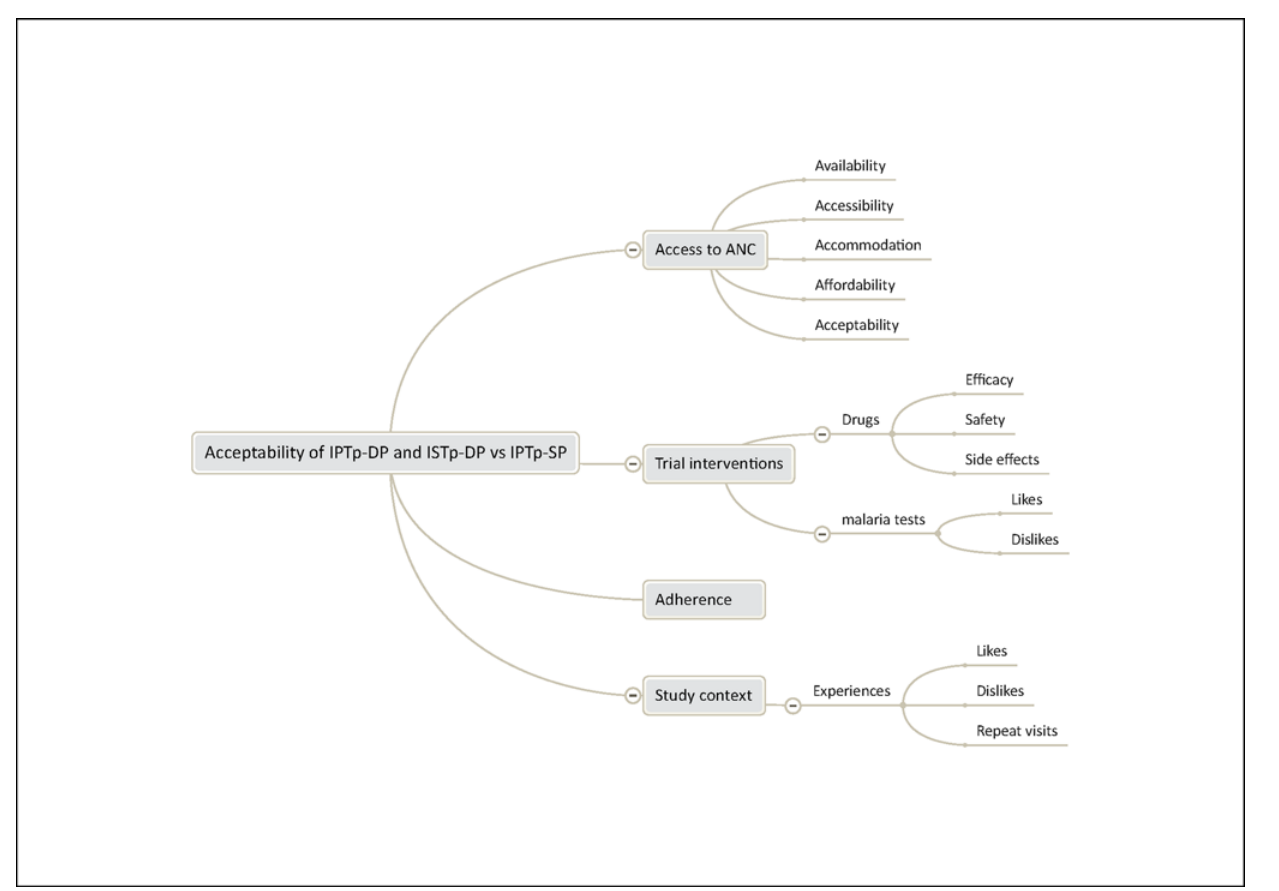
Fig 2. Analysis framework for focus group discussions with trial